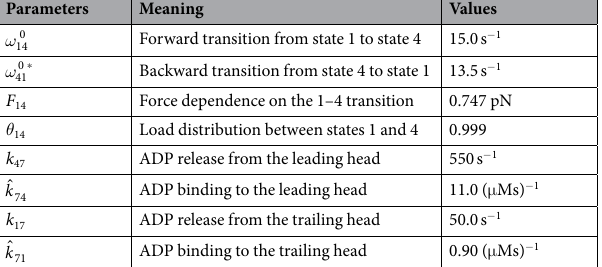
Table 1. Transition rates employed in the three-state network model shown in Fig. 1b. The definition of the parameters is provided at “Motor dynamics” in the Method section. * Determined by the extended detailed balance condition (see Supplementary